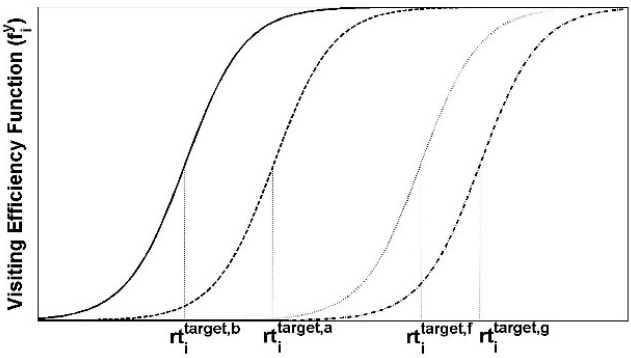
Figure 2. Visiting efficiency function for different visiting styles of the museum visitors.